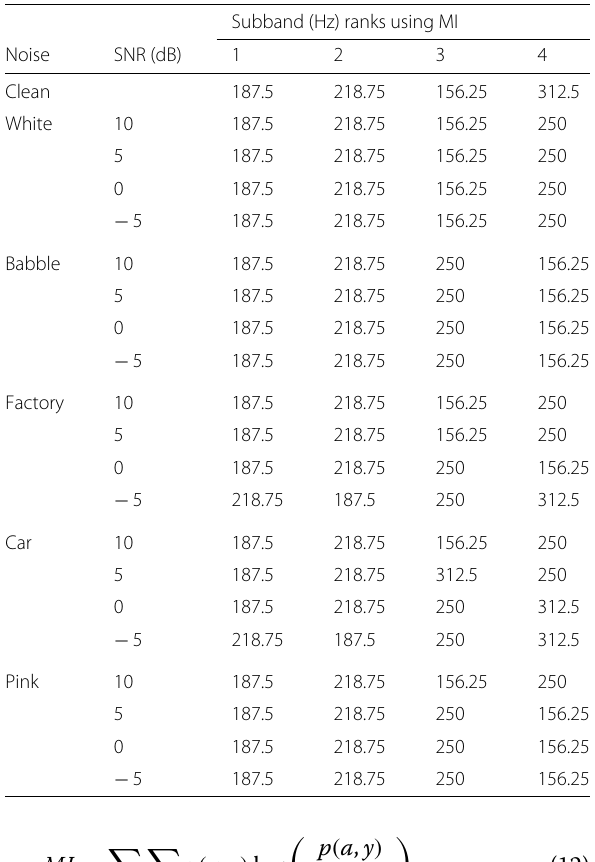
Table 3 Subband (Hz) ranks using mutual information (MI) Subband (Hz) ranks using MI